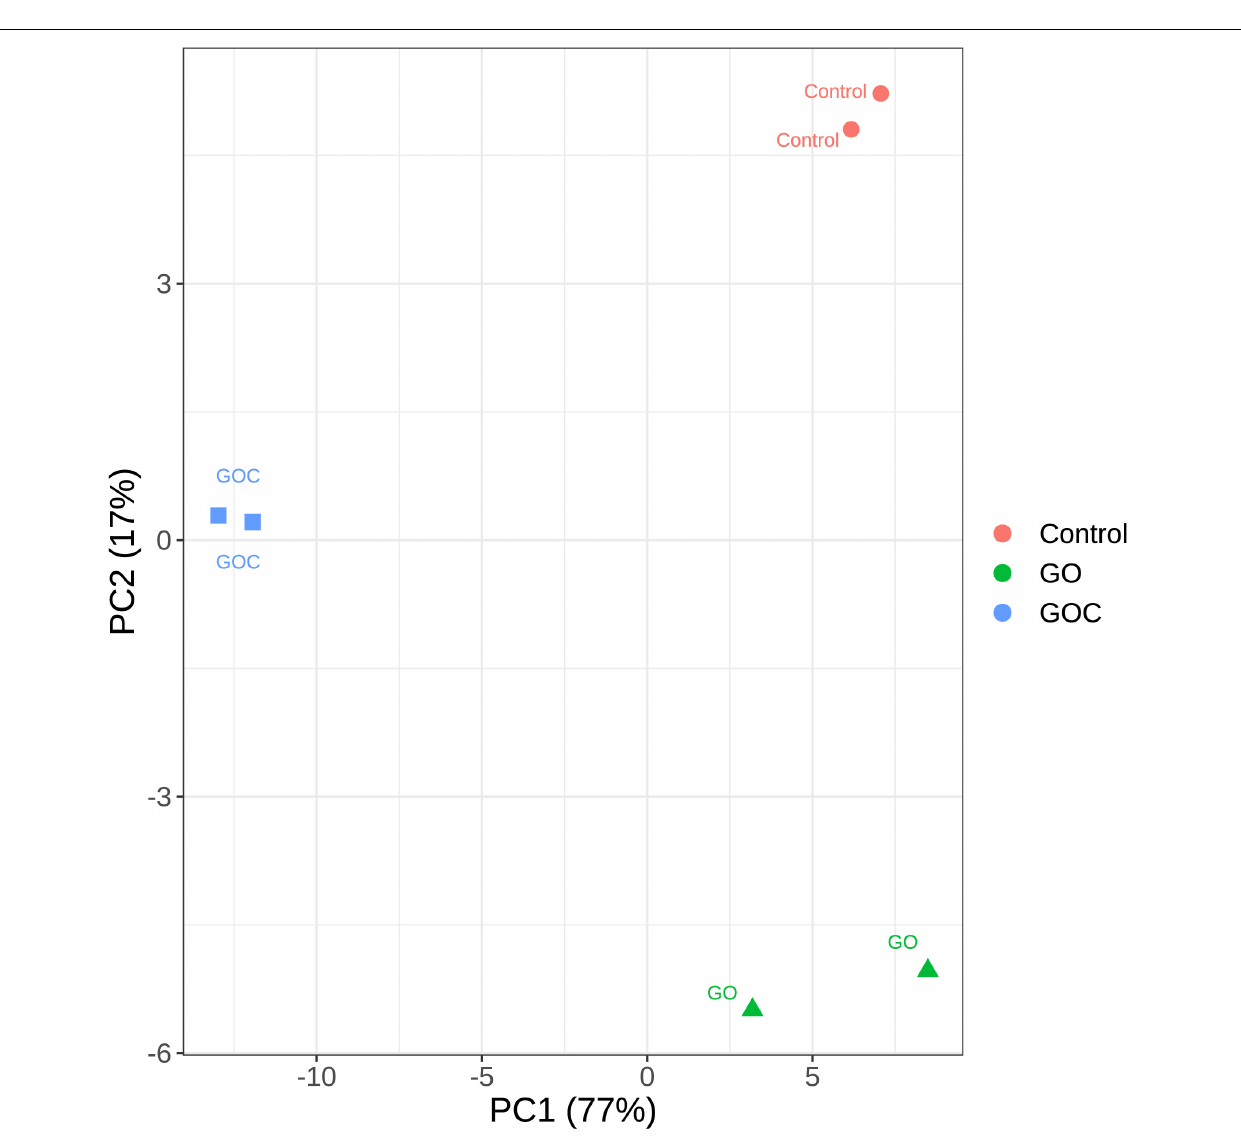
FIGURE 2 | Principal Component Analysis plot of the transcriptomic response of S. cerevisiae to two different graphene oxide products at 160 mg L − 1 (Control: non-exposed cells, GO: exposed to monolayer graphene, and GOC: exposed to graphene oxide nanocolloids). Only the top 500 genes with most variability were